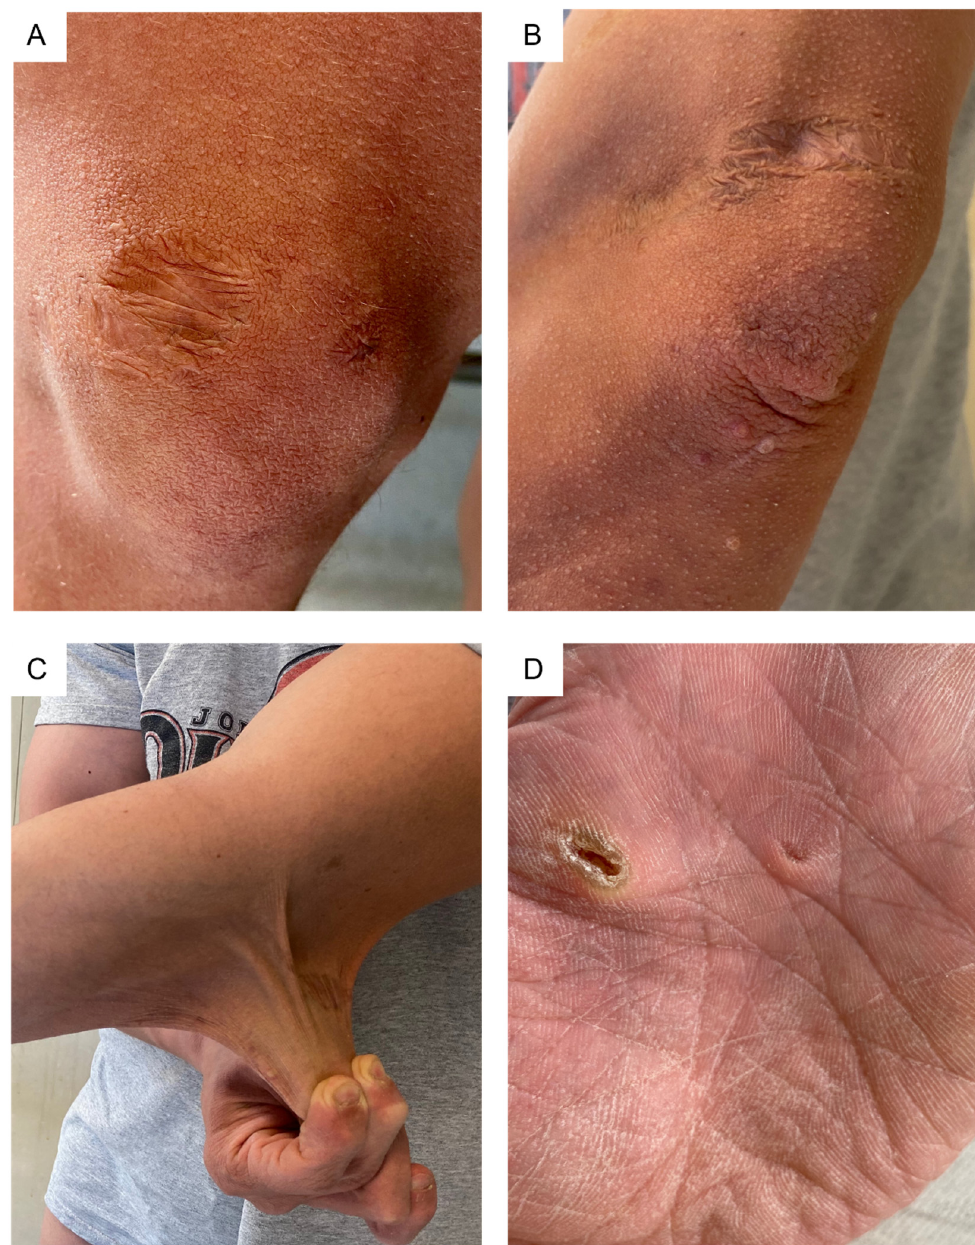
Figure 3. Skin examination: ( A , B ) atrophic and hemosiderotic scars of the knee and elbow, the latter also showing small molluscoid pseudotumors and skin wrinkling/acquired cutis laxa.; ( C ) marked skin hyperextensibility; ( D ) hyperlinear palm with pits, callosities, and apparently aberrant keratinization .